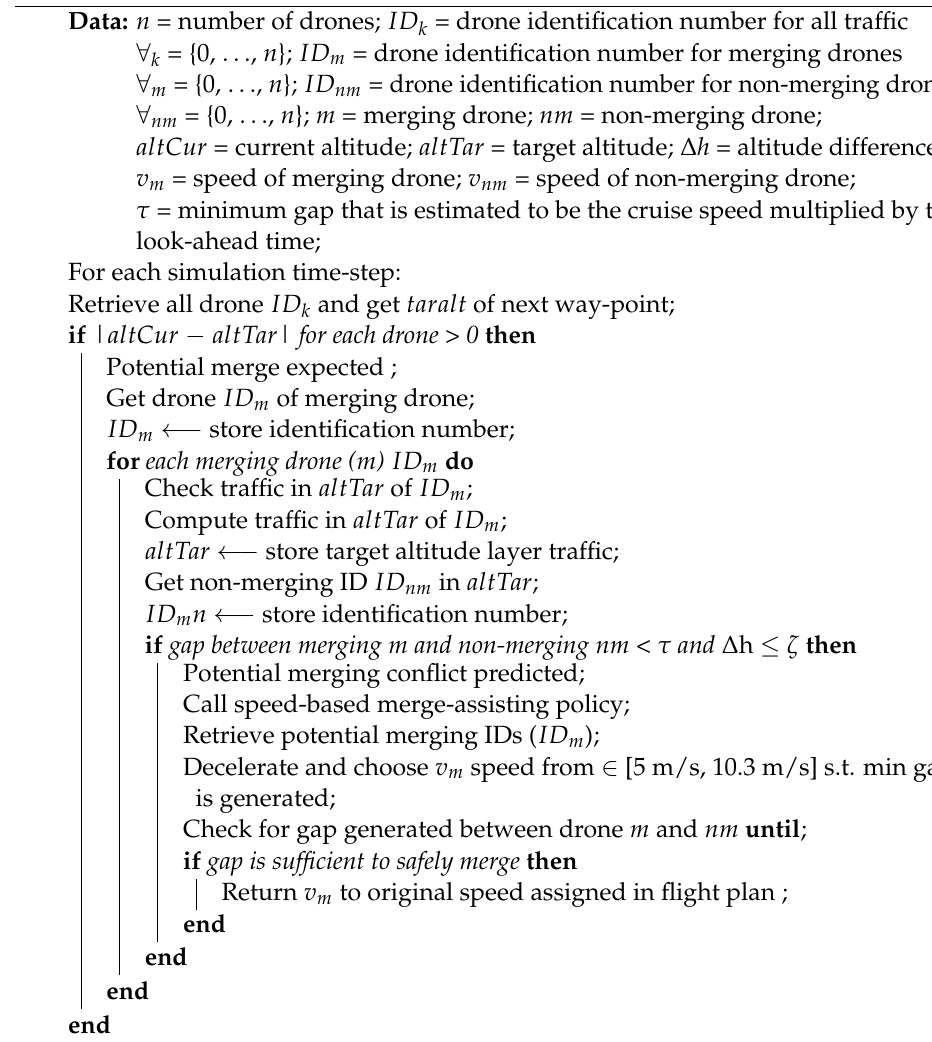
Algorithm 2: Speed-based merge assistance